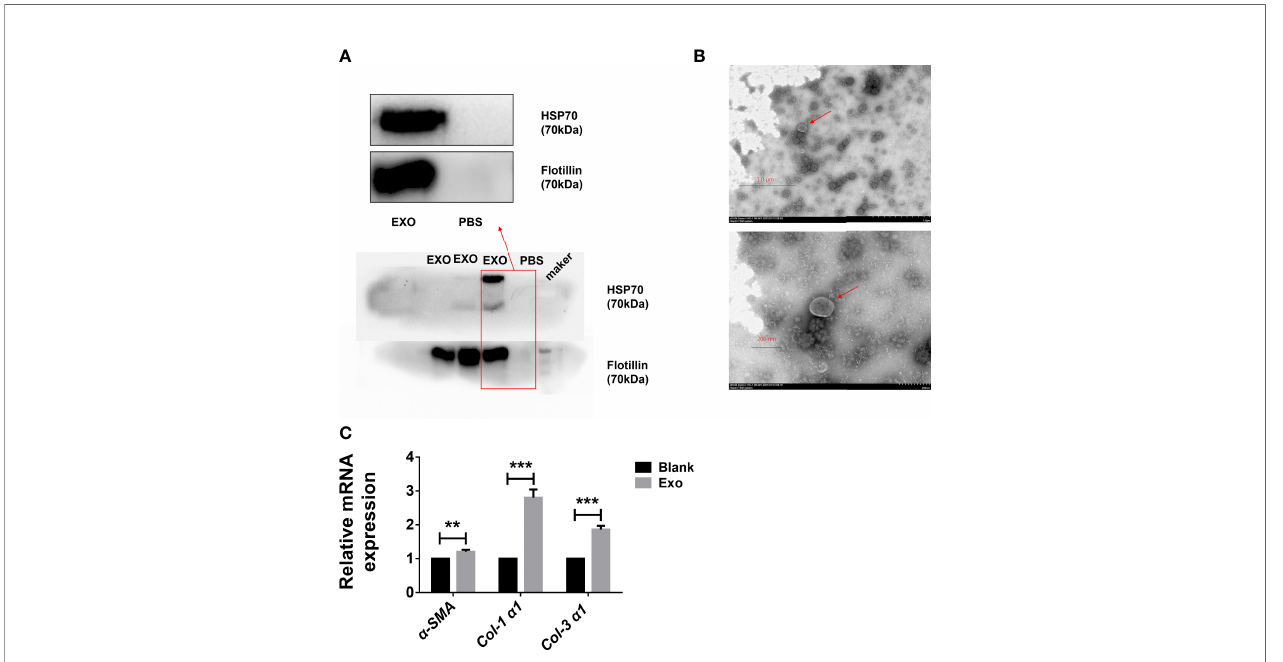
FIGURE 1 | Egg-derived exosomes from Schistosoma japonicum can promote liver fi brosis. (A) Western blotting detection of markers of egg-derived exosomes of S. japonicum . (B) Transmission electron microscopy (TEM) analysis of exocrine. (C) At 24 h after stimulation of LX-2 human hepatic stellate) cells (HSCs) by egg- derived exosomes of S. japonicum , mRNA levels of smooth muscle actin ( a -SMA), collagen (Col) 1 ( a 1) , and collagen (Col) 3 ( a 1) were measured by qPCR. Results are averaged from three independent experiments, and Student ’ s t -tests were applied to assess differences between two groups. The mRNA expression levels of a -